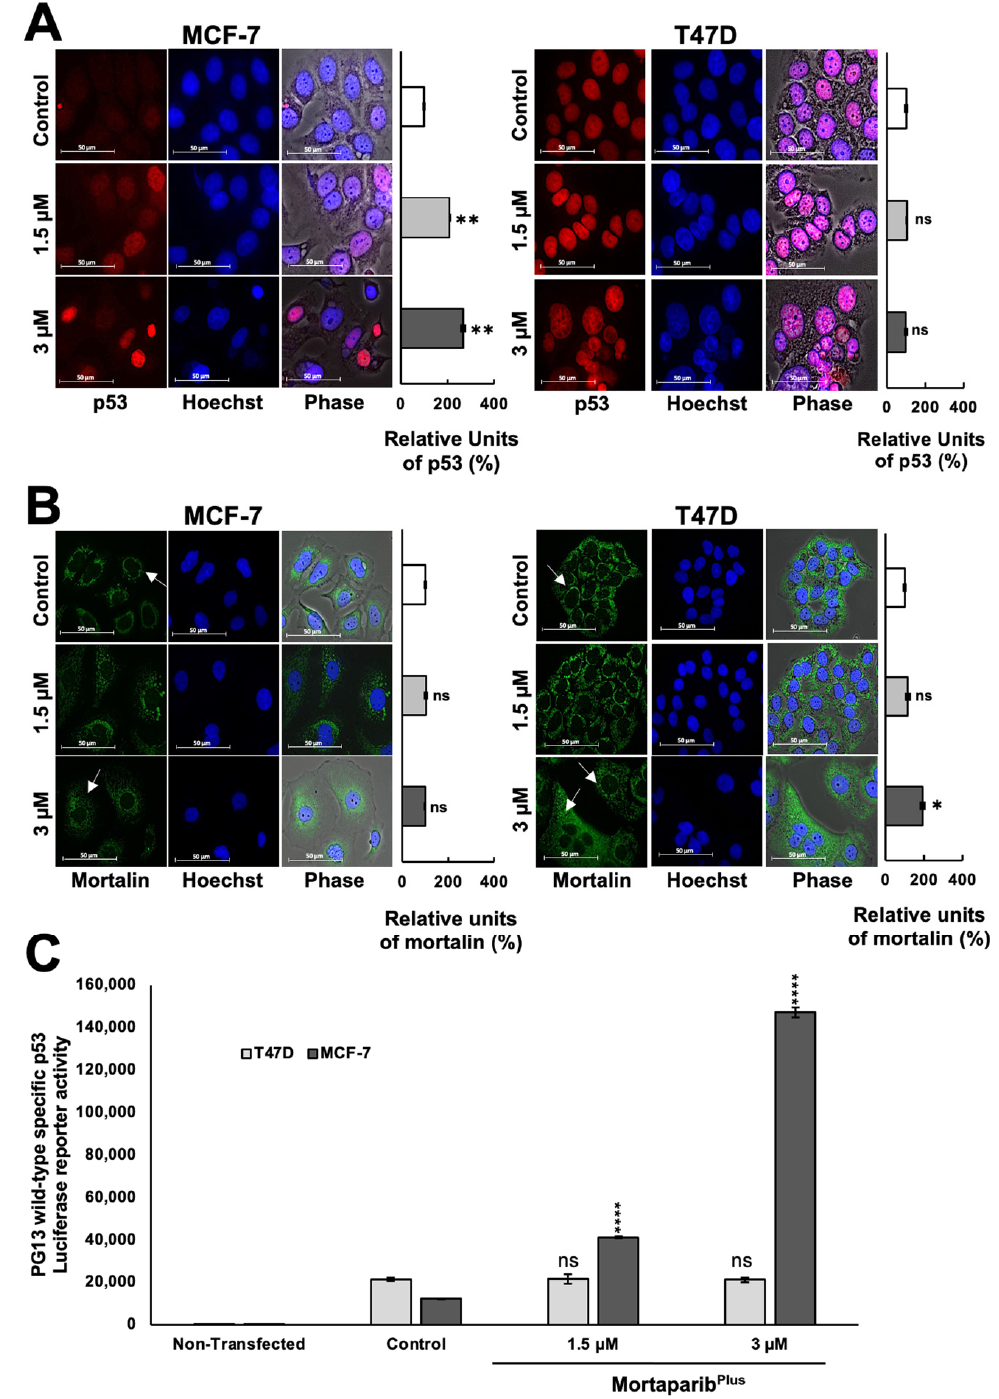
Figure 3. Mortaparib Plus caused nuclear translocation of p53. The sub-cellular localization of p53 and mortalin in the control and 48 h-Mortaparib Plus -treated cells was examined by immunocytochemistry ( A , B ). Mortaparib Plus -treated MCF-7 cells showed p53 enrichment in the nuclei as compared to the nuclei of untreated control. T47D cells showed the mutant p53 L194F in the nuclei of both the 48 h-Mortaparib Plus -treated and untreated ones. The shift of the mortalin staining pattern from perinuclear in control to pan-cytoplasmic in Mortaparib Plus -treated MCF-7 and T47D cells was also observed (shown by white arrows). The transcriptional activation function of p53 was examined by the p53 wild-type specific luciferase reporter (PG13-Luc) assay ( C ). The wild-type p53-dependent luciferase reporter activity showed a dramatic increase in Mortaparib Plus -treated MCF-7, but not T47D, cells. Scale bar: 50 µ m. The quantified data represent mean ± SD obtained from independent biological replicates; p -values were calculated using unpaired Student’s t -test. ns > 0.05, * ≤ 0.05, ** ≤ 0.01, and **** ≤ 0.0001 represent significant, non-significant, very significant, and extremely significant,